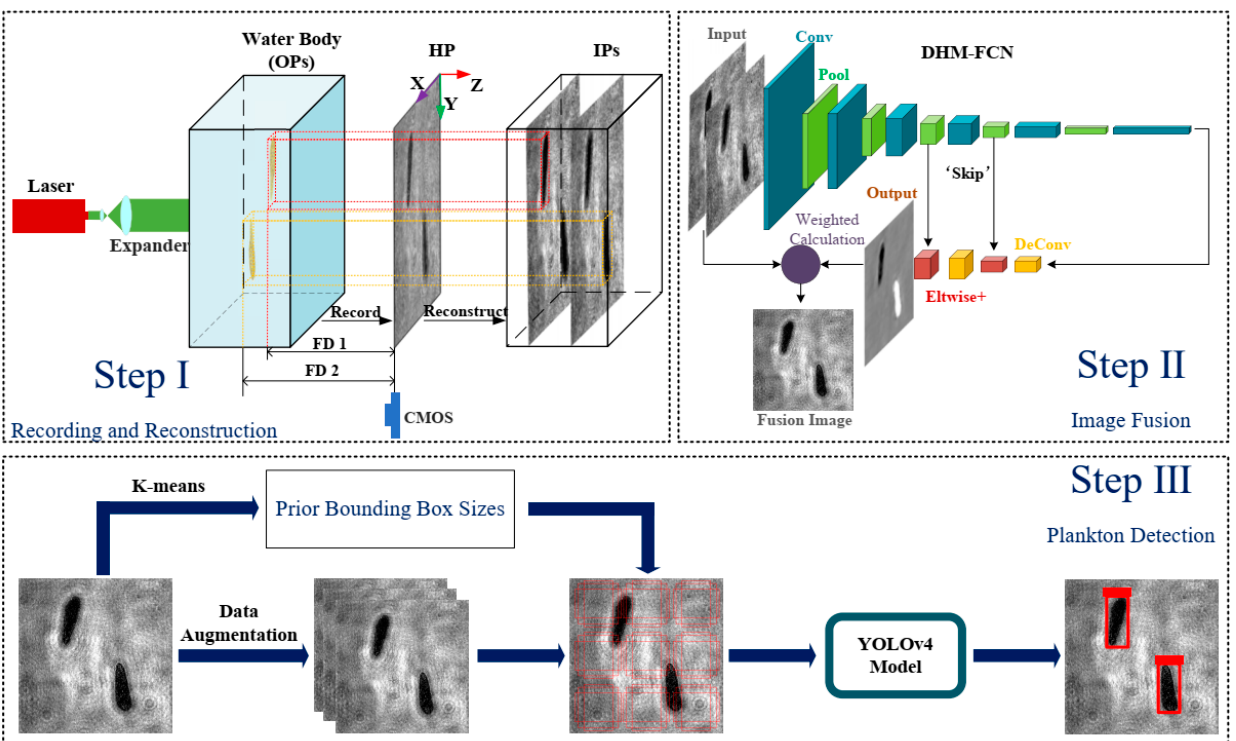
Figure 1. The procedures of plankton detection. In Step I, OP represents object plane, HP represents hologram plane, IP represents image plane, and FD represents focus distance. In Step II, the inputs of the model are the two reconstructed holograms; the output of the model is the label graph.